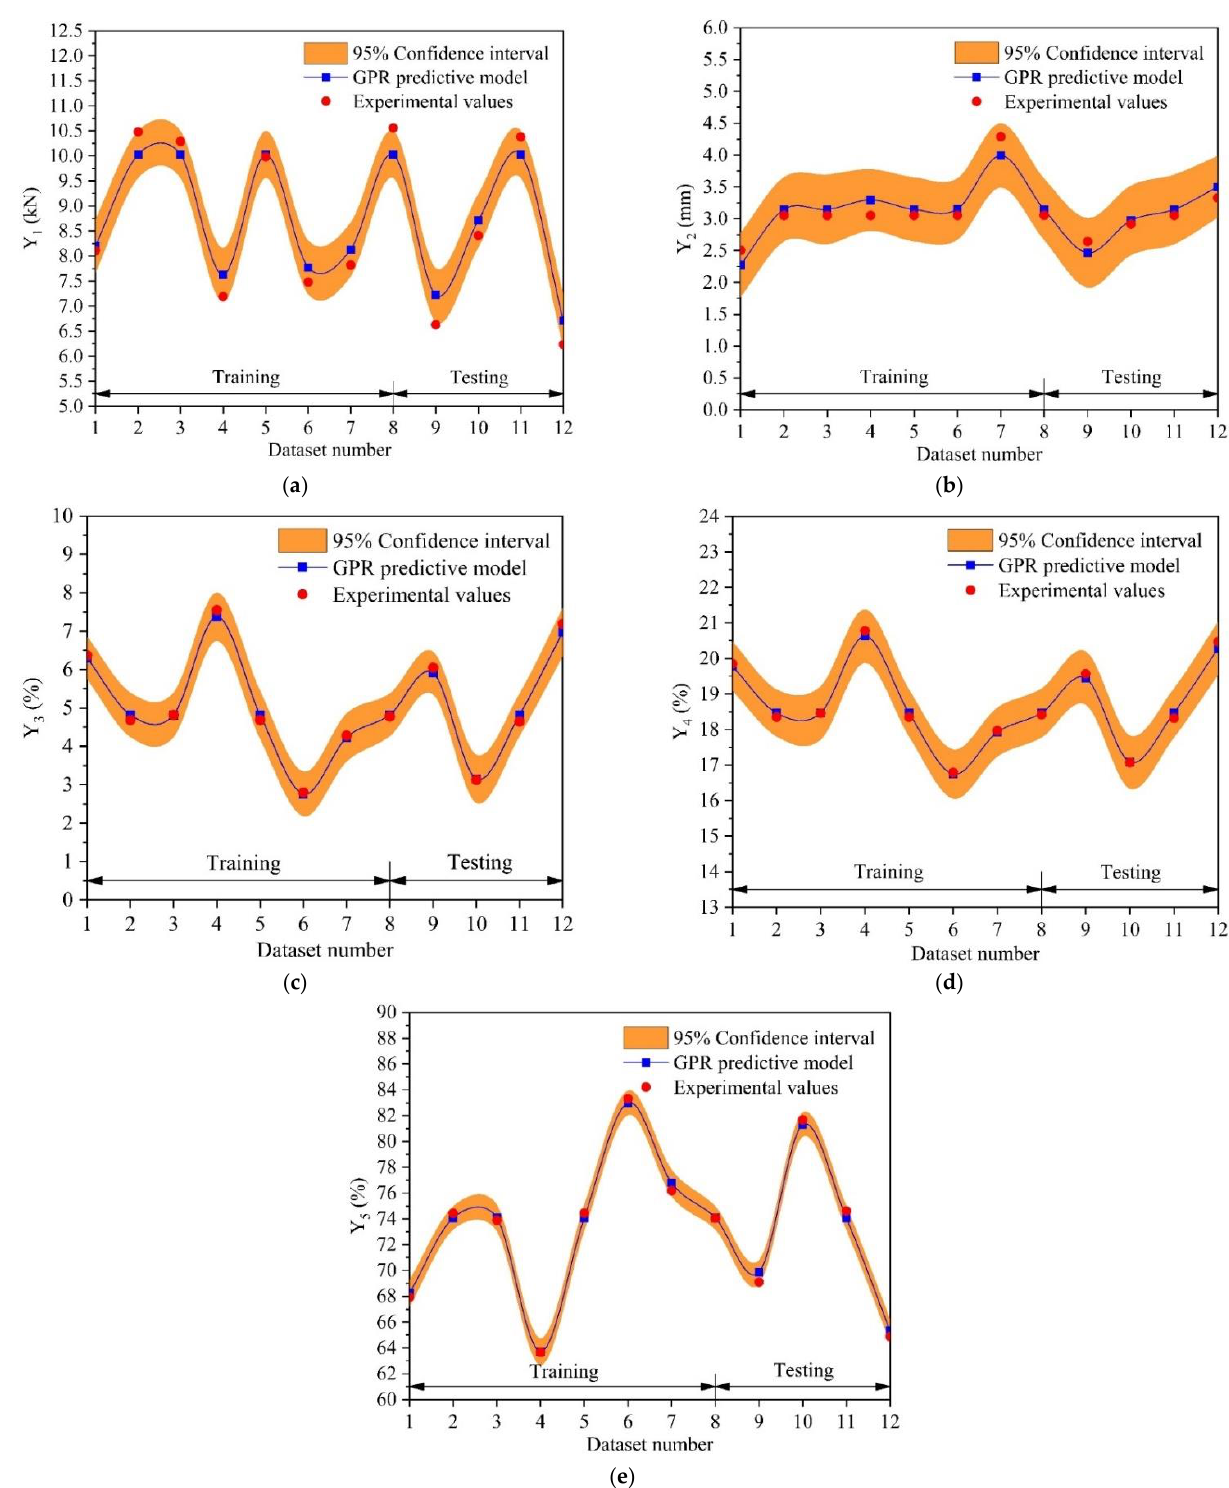
Figure 6. Comparison of the predictive values by GPR versus the experimental values: ( a ) Y 1 ; ( b ) Y 2 ; ( c ) Y 3 ; ( d ) Y 4 ; and ( e ) Y 5 .